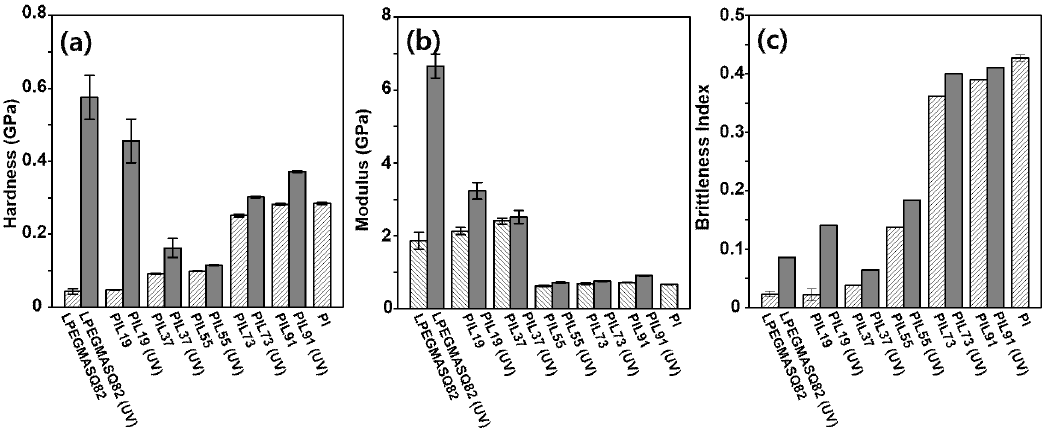
Figure 8. Nanoindentation results for hybrid composites showing measured: ( a ) hardness, ( b ) modulus, and ( c ) brittleness indices.